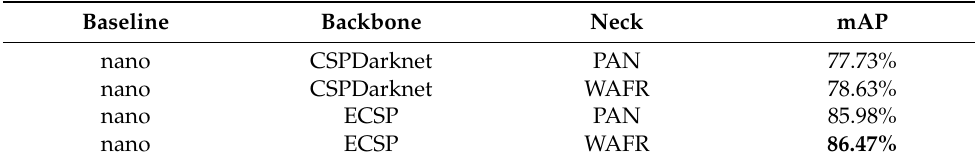
Table 8. Ablation experiments for WAFR.